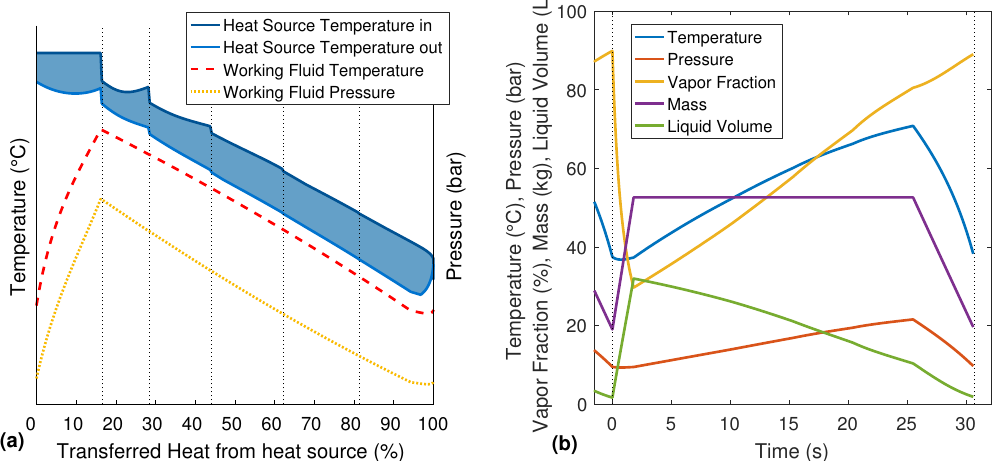
Figure 4. Diagrams of the Misselhorn cycle for six heat exchangers: ( a ) quasi-continuous T-Q-diagram; ( b ) time variations of the system